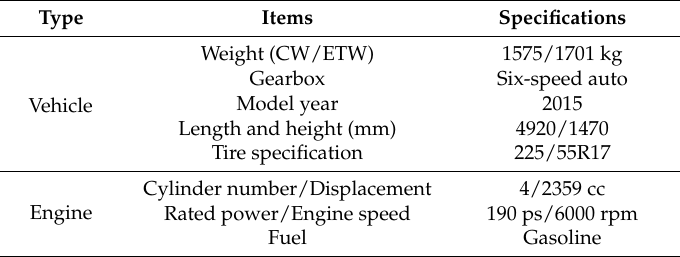
Table 5. Specifications of the test engine and vehicle. CW: curb weight; and ETW: equivalent test weight. Type